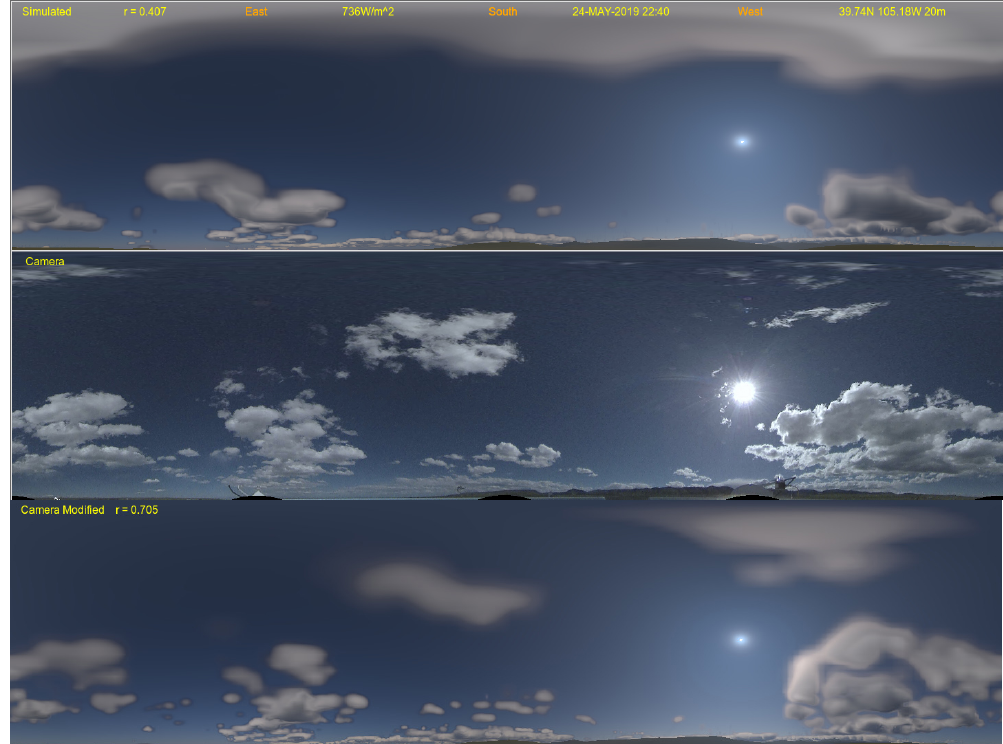
Figure 14. SWIm image from a 3D LAPS cloud analysis using satellite data without camera input (top) is shown with a camera image (middle) and the SWIm image using 3D clouds, modified via a color ratio algorithm (bottom). The NREL camera image is from 24 May 2019 at